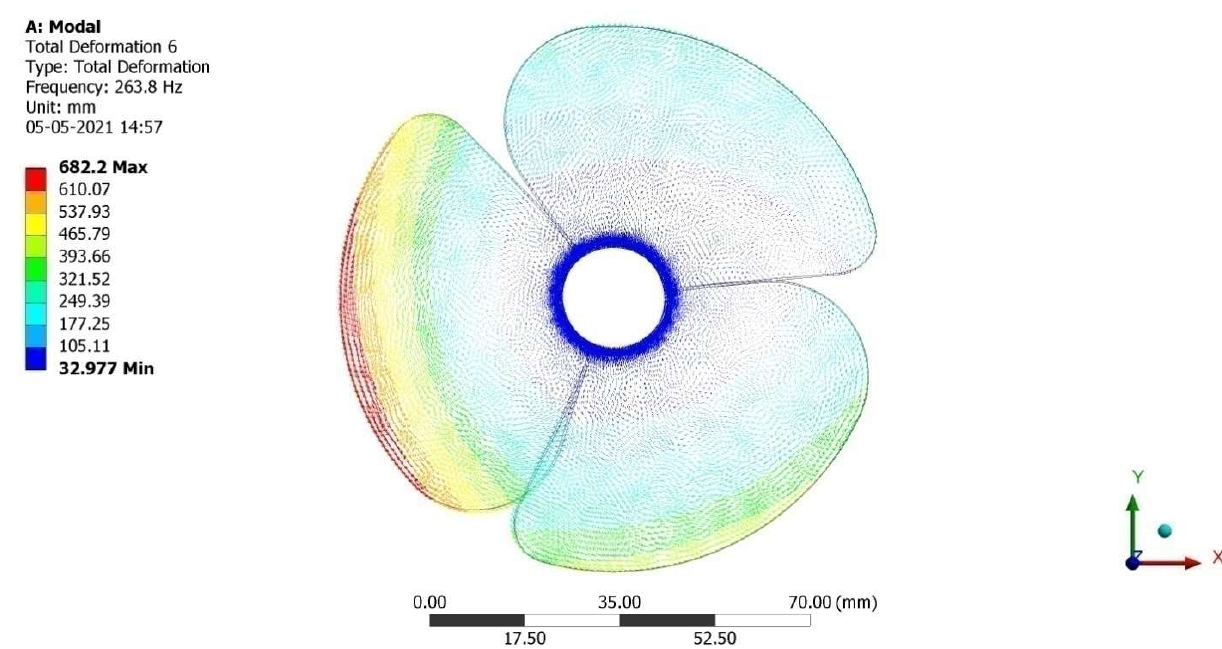
Figure 46. Sixth mode shape outcome of FR-4-GFRP-woven based composite.